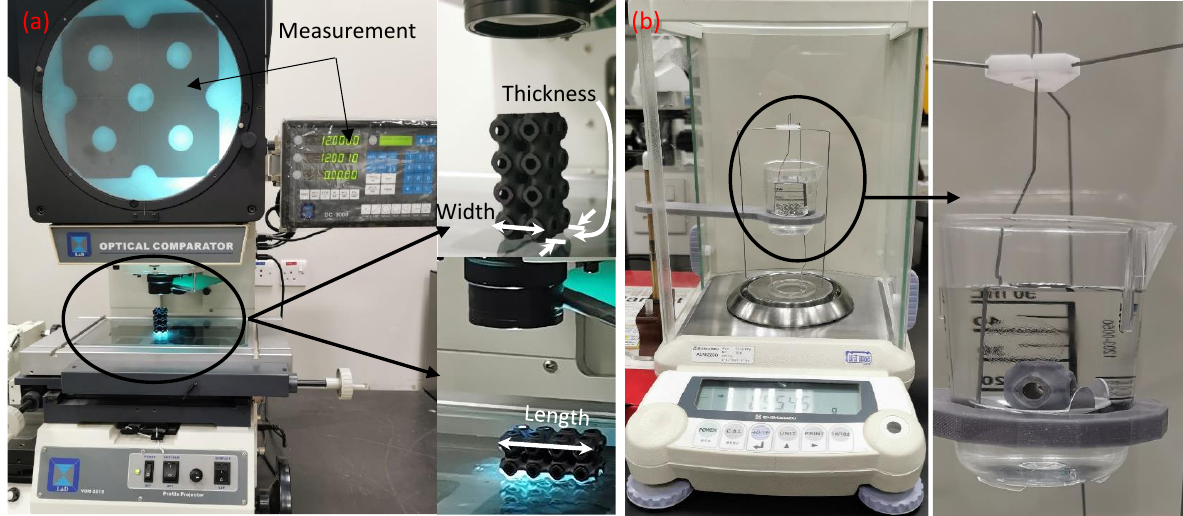
Figure 3. Measuring setups: ( a ) dimension measurements and ( b ) density measurements.